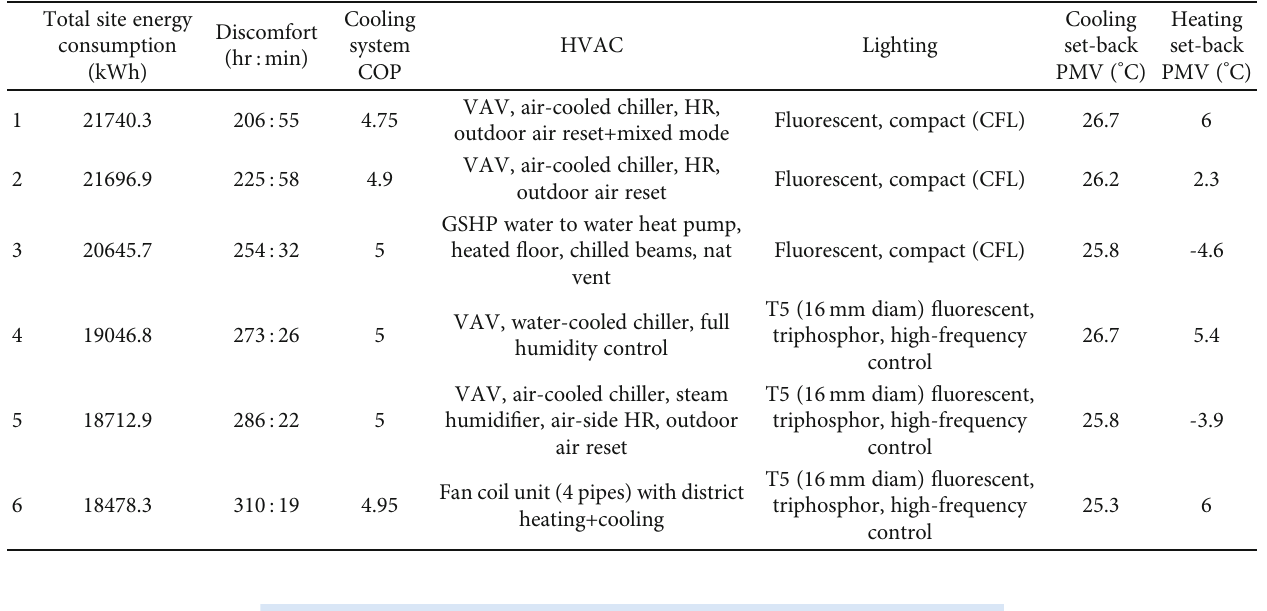
Table 5: Optimization of Pareto Front.